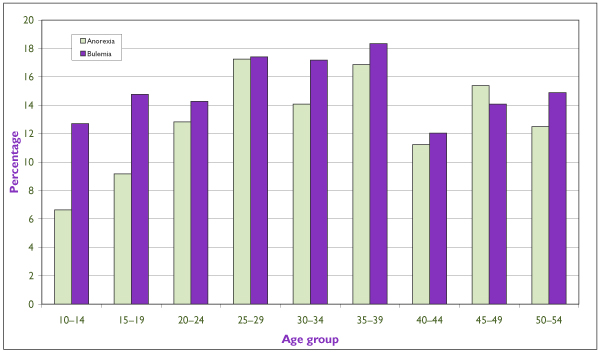
Canadian Inpatient Age-specific Prevalence for Depression Among Women with Anorexia, Bulimia and Eating Disorder Not Otherwise Specified, 2000 Source: Canadian Institute for Health Information